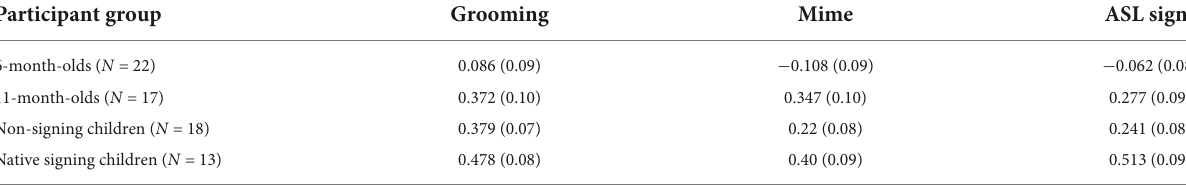
TABLE 3 Mean face preference index (FPI) values for each group and condition. Participant group